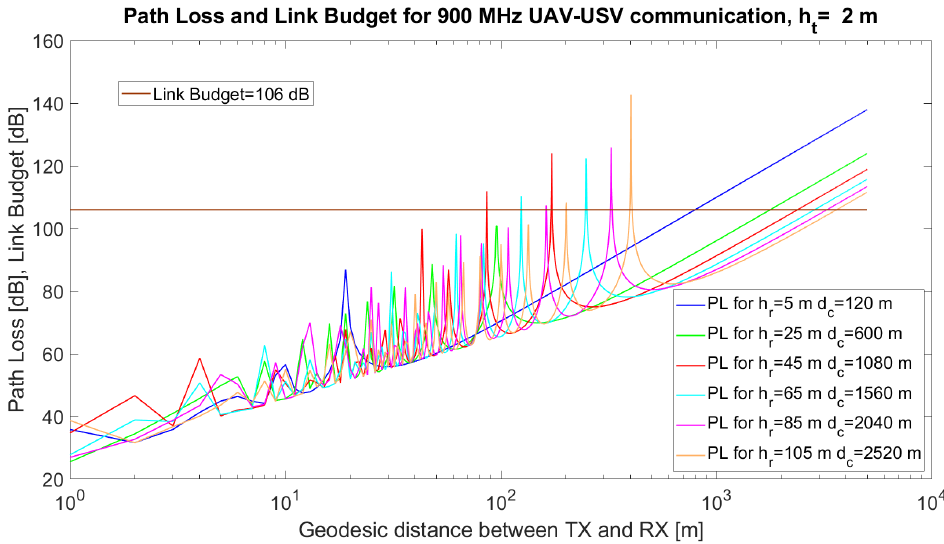
Figure 4. Path loss, link budget and critical distance for UAV–USV link, when USV antenna height is h t = 2 m and the solution in [57] is